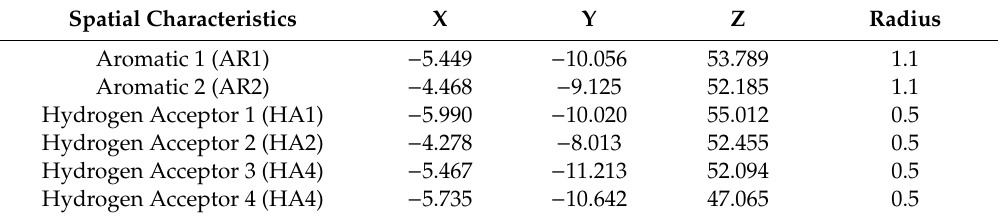
Figure 2. Pharmacophore model of adenosine A 2A receptor (A 2A AR) agonists obtained using the PharmaGist web server. Aromatic rings (AR) are represented in purple and hydrogen acceptor (HA) groups are represented in orange. Table 1. Coordinates and radius of the spatial features of the selected pharmacophore model. Spatial